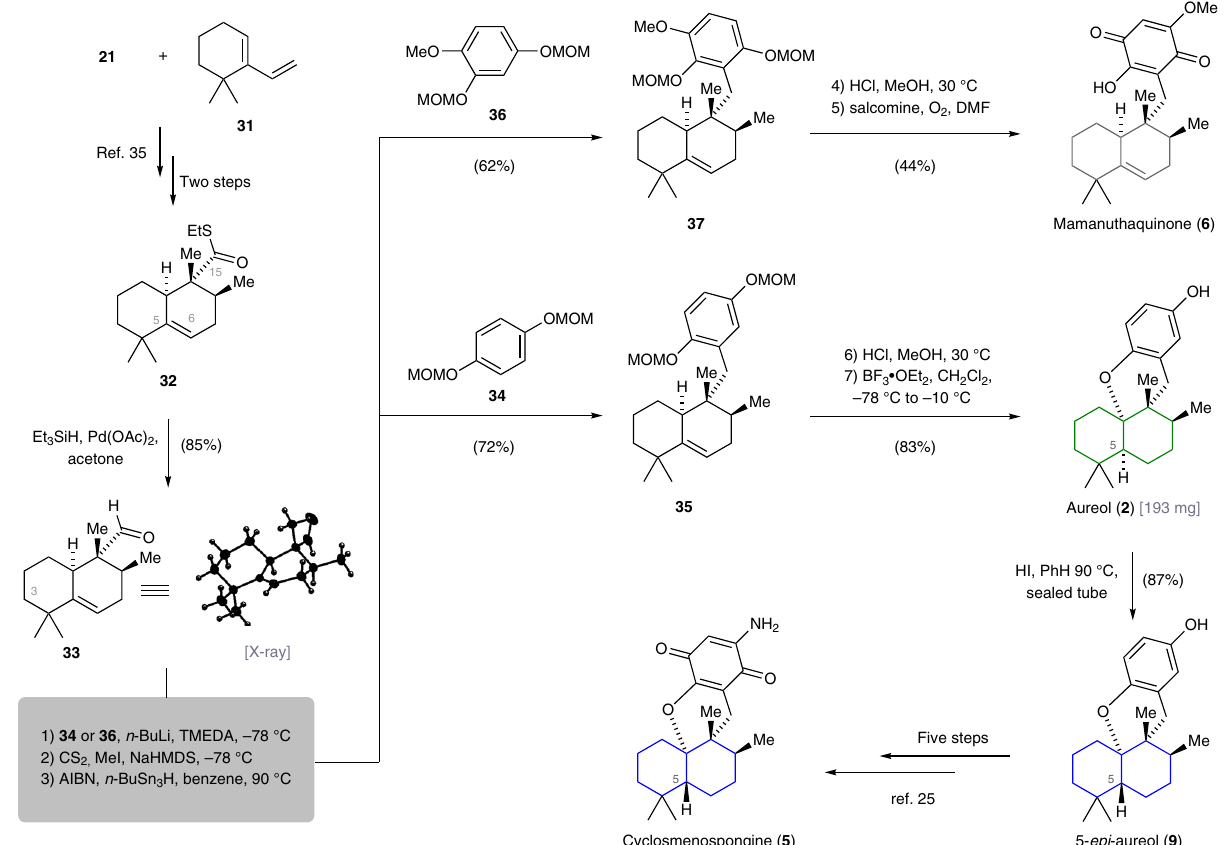
Fig. 5 Chemical synthesis of (+)-aureol ( 2 ), ( – )-cyclosmenospongine ( 5 ), ( – )-mamanuthaquinone ( 6 ), and (+)-5- epi -aureol ( 9 ). The 3-deoxy-5,6- dehydrodecalin unit 33 was accessed in three steps from the known coupling of 21 and 31 . Installation of the C15 – C16 carbon – carbon bond was accomplished by ortho -directed lithiation of 34 or 36 and nucleophilic addition to 33 . AIBN azobisisobutyronitrile, NaHMDS sodium hexadimethylsilazide, TMEDA N , N , N , N ′